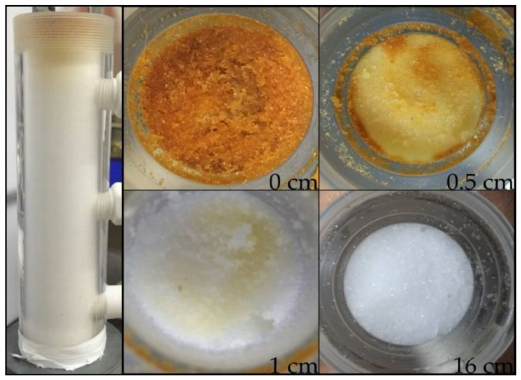
Figure 9. Porous matrix iron oxide particles interception for different